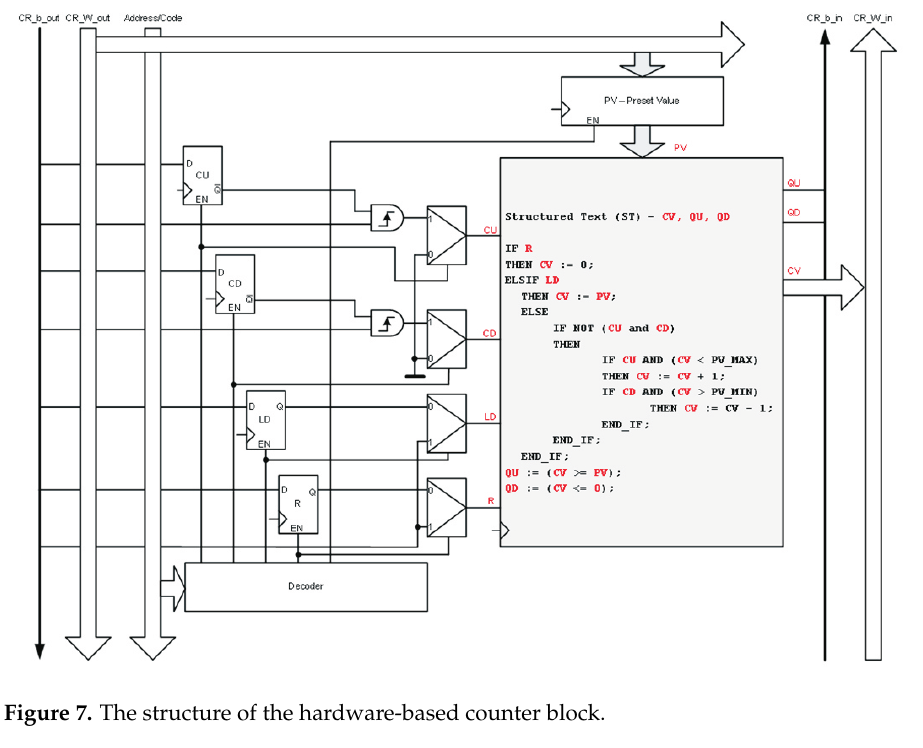
Figure 7. The structure of the hardware-based counter block.